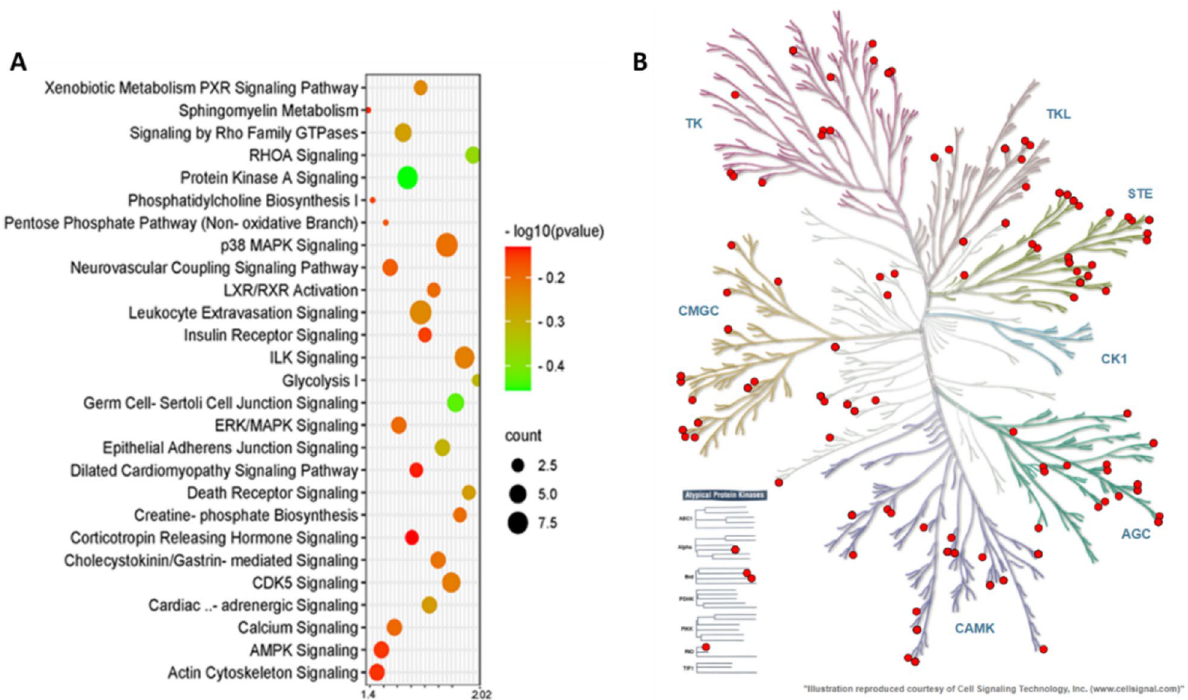
Figure 4. Top canonical pathway analysis and the kinome tree analysis of the adipose tissue phospho-proteome of postpartum (PP) dairy cows supplemented with ALA 20 min after glucose infusion. Dairy cows were divided into two groups from 21 to 60 days PP; (i) CTL—encapsulated saturated fat, (ii) ALA—flaxseed supplement providing α-linolenic acid (ALA). n = 5 per treatment. ( A ) Top canonical pathways associated with ALA supplementation of dairy cows on the Y-axis and—log (P-value) on the X-axis. The size and color of each bubble represent the number of peptides in each pathway and the P value, respectively. ( B ) The predicted kinases of phospho-proteome in ALA-supplemented AT as represented in the kinome tree using the kinmap server. The identified kinases of the Phosphoproteome of dairy cows are represented as follows: AGC PKA/PKG/PKC- family kinases, CAMK calcium/calmodulin-dependent kinases, CK1 casein kinases, CMGC CDK/MAPK/GSK3/ CLK-family kinases, STE sterile homologue kinases, TK tyrosine kinases, TKL tyrosine kinase-like kinases. The kinases are separated and denoted as red circles on the branches of the tree based on their